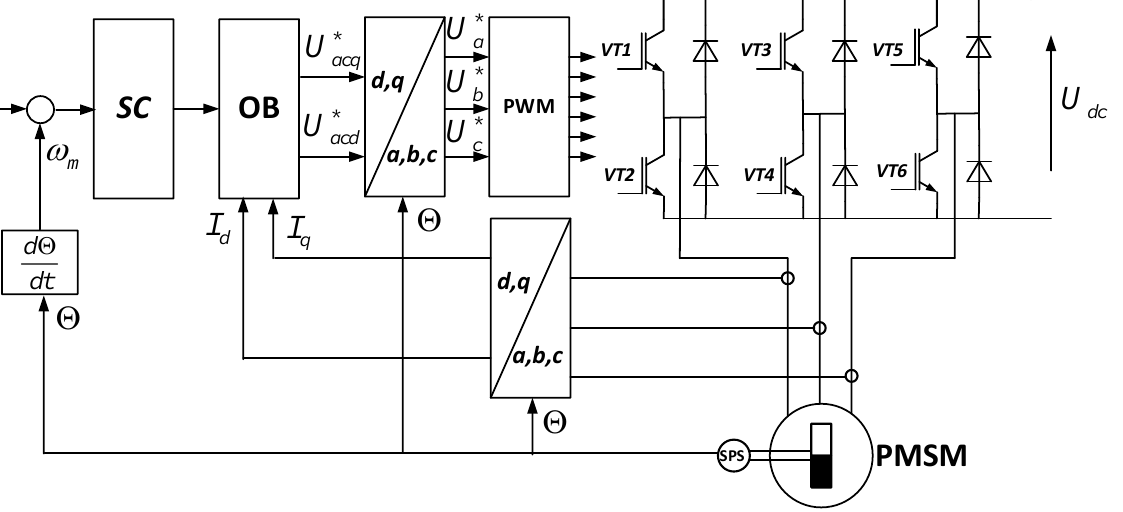
Figure 6. PMSM control system with PWM and speed regulator with energy optimization (Qac = 0).